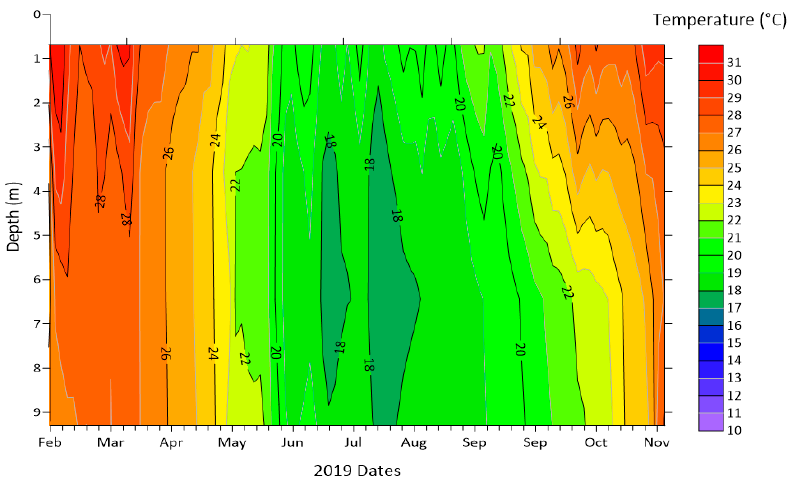
Figure 4. Temperatures in Bowen Lake 2 (February–November 2019) as measured by in situ continuous monitoring chains.